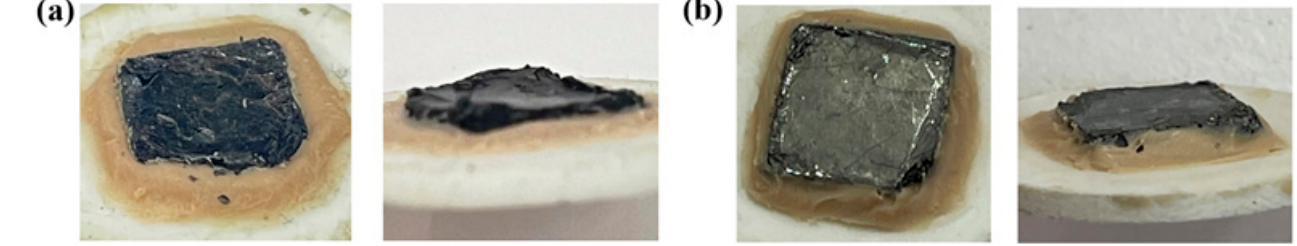
Figure 8. Optical micrograph of HOPG after 3 cycles of CV. ( a ) LCE, ( b )